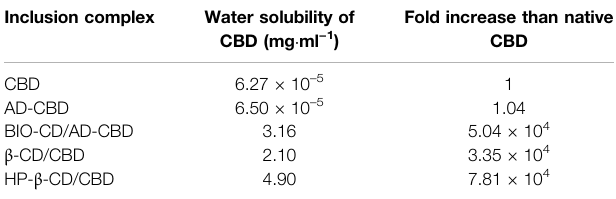
TABLE 1 | The chemical shift changes of BIO-CD protons formed inclusion complex with AD-CBD in D 2 O at 25 ° C.